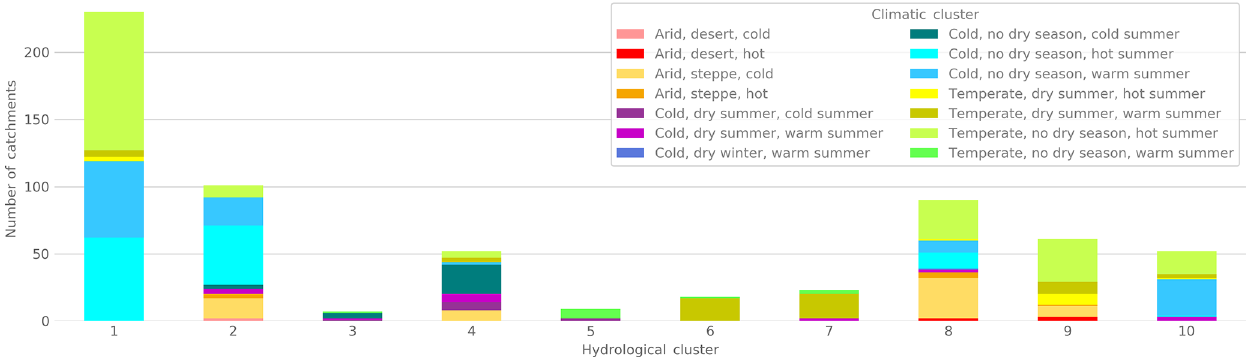
Figure 10. Membership of Köppen–Geiger clusters (Beck et al., 2018) in the hydrological